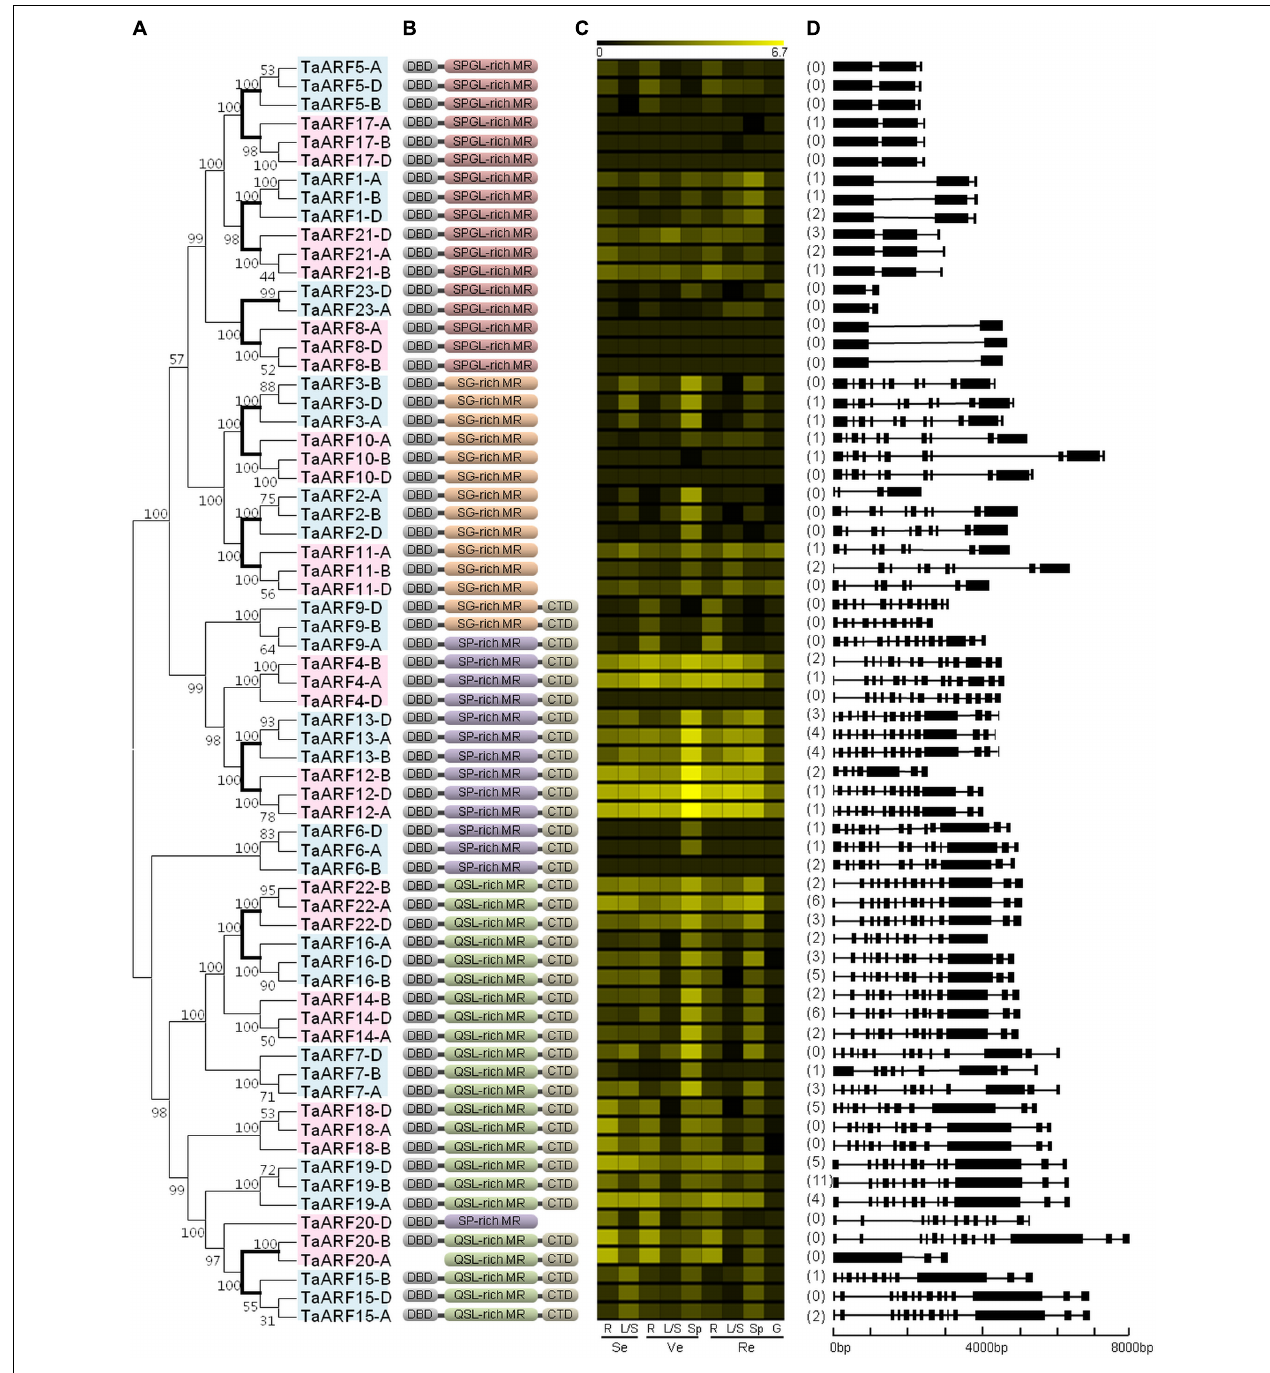
FIGURE 1 | Phylogenetic relationships, domains, in silico expression profiling, and gene structure of ARFs in wheat. (A) Phylogenetic tree of TaARFs constructed from the complete alignment of 68 wheat ARF protein sequences by the neighbor-joining method with 1000 bootstrap replicates using MEGA 6.0. The bootstrap scores are indicated on the nodes, and the 23 TaARF members, all of which are coded by homeoalleles, are indicated in blue or pink boxes. The branch of paralogous TaARF members is shown in bold. (B) Conserved domains of TaARFs. DBD, DNA-binding domain; CTD, C-terminal dimerization domain; MR, middle region; S, serine; P, proline; G, glycine; L, leucine; Q, glutamine. (C) In silico expression profiling of TaARF homeoalleles in different organs at different growth stages of Chinese Spring wheat. The expression data were generated from the expVIP database (http://www.wheat-expression.com/). The color scale at the top represents the expression values: black indicates low levels of transcript abundance, and yellow indicates high levels. R, root; L/S, leaf/stem; Sp, spike; G, grain; Se, seedling stage; Ve, vegetative stage; Re, reproductive stage. (D) Exon/intron structures in the CDS of TaARF genes. The number of AS variants is listed before each gene. For genes that represent predicted AS variants, the variant with the highest in silico expression level has been selected for the gene structure analysis. Exons are represented by black boxes and introns by black lines. The size of exons and introns can be estimated using the scale at the bottom.